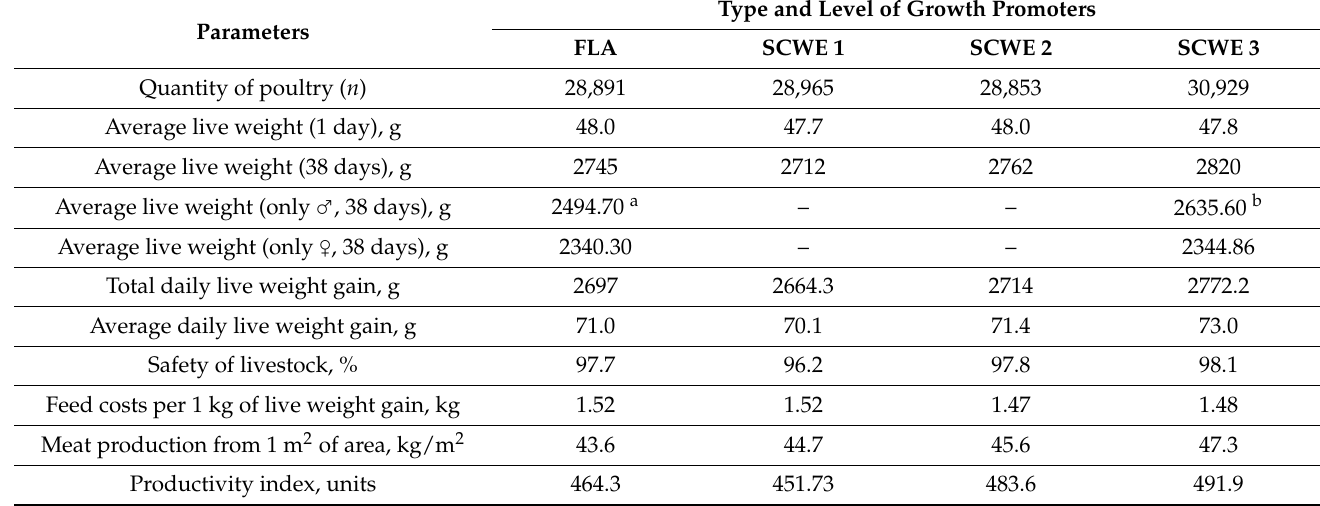
Table 5. Zootechnical indicators of growing broiler